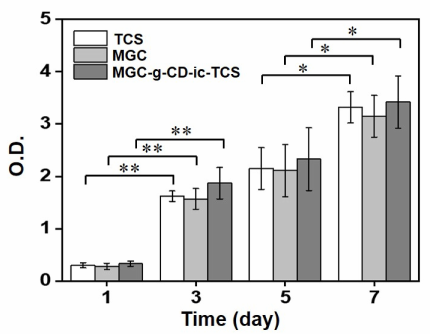
Figure 4. In vitro cell proliferation of L-929 cells cultured on TCS, MGC, and MGC-g-CD-ic-TCS for 1, 3, 5, and 7 days. This test was performed in triplicate ( n = 3; * p < 0.05, ** p <